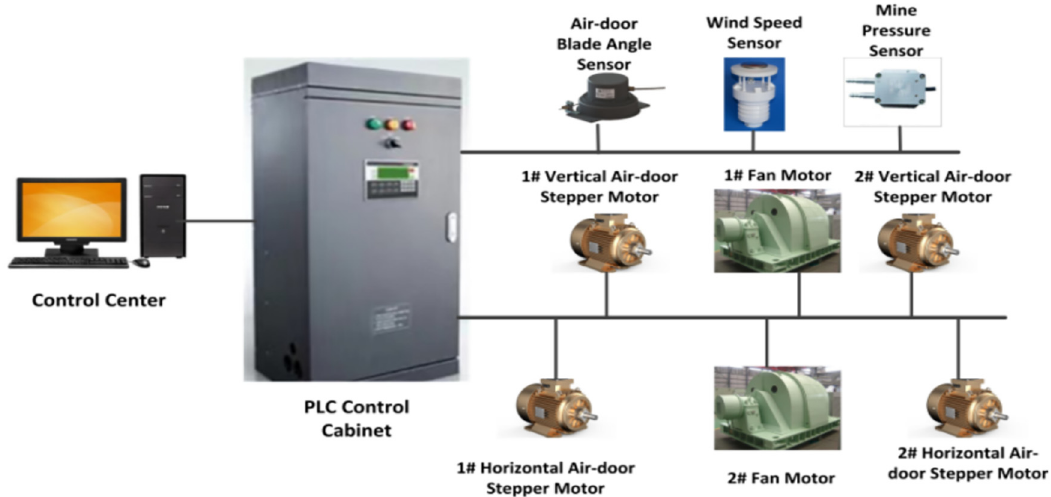
Fig. 3. Schematic diagram of the no-stop switchover system of main mine fans based on intelligent control.